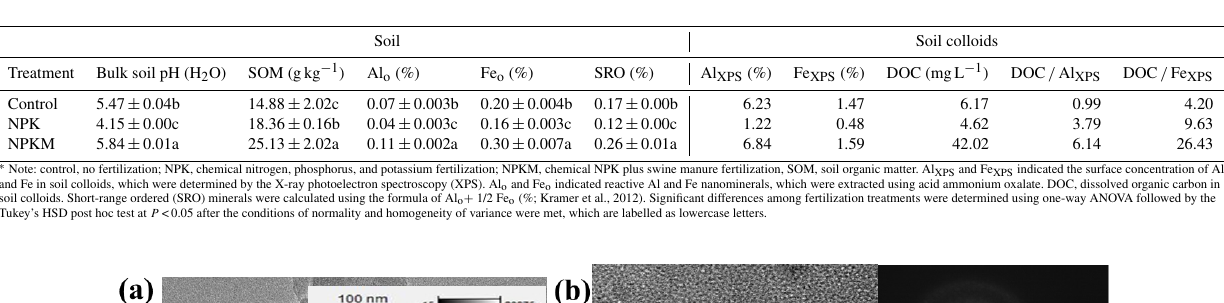
Table 1. Basic physiochemical characteristics of soil samples from three contrasting long-term (1990–2014) fertilization treatments ∗ . Soil Soil colloids